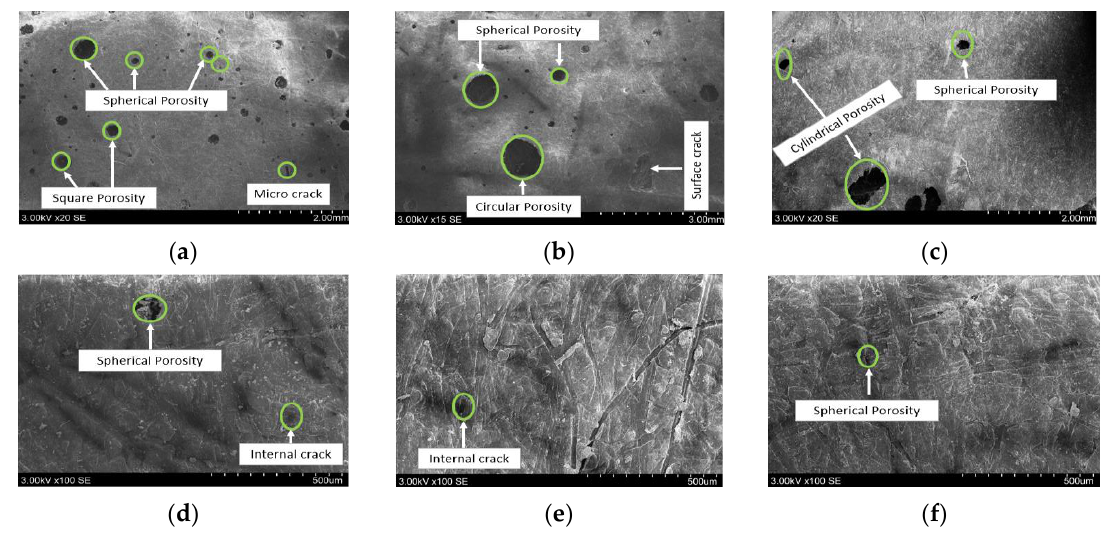
Figure 10. Porosity content in basalt and E-glass woven-fiber hybrid composites ( a ) B, ( b ) E, ( c ) B/E, ( d ) B/E/G5, ( e ) B/E/G10 and ( f ) B/E/G15.